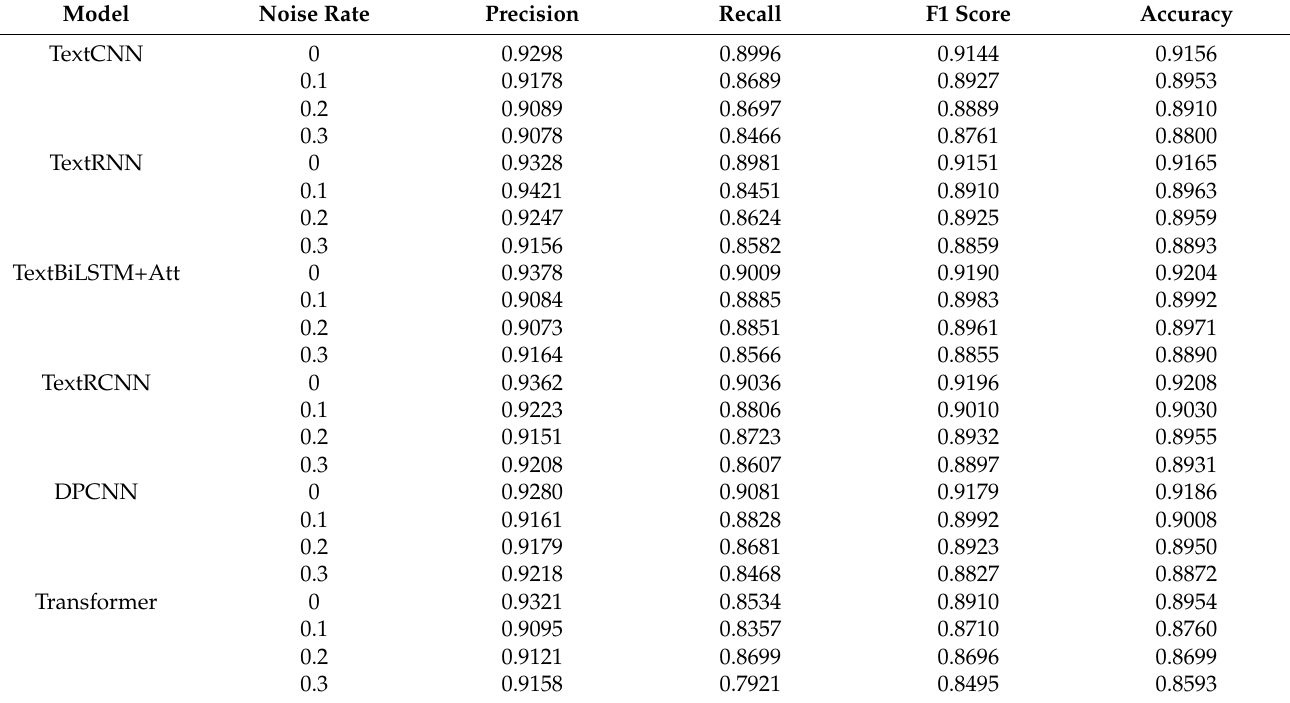
Table 4. Comparison of the results with different homophonic noise rates with the commonly used deep learning models and the BiGRU-CNN-JE